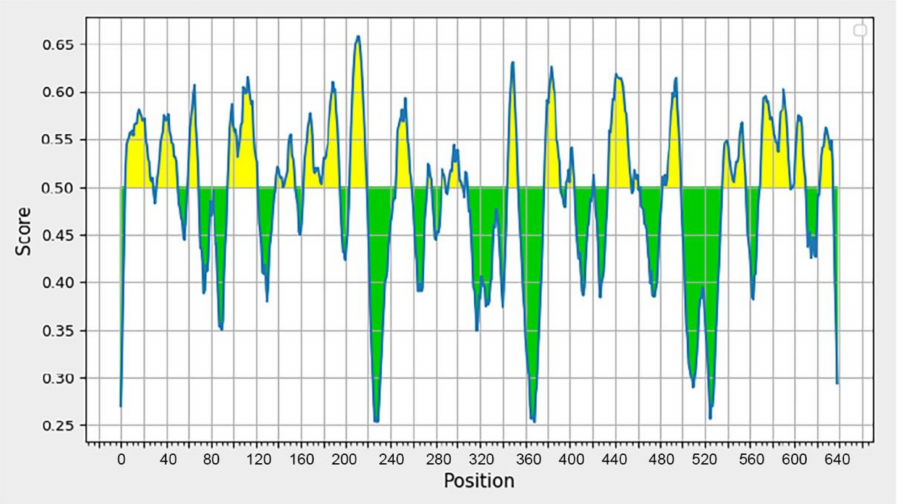
Figure 2. Graph displaying the results of B-cell epitope prediction using BepiPred Linear Epitope Prediction 2.0. The graph illustrates two prediction areas: the area with a yellow peak over the red line (threshold), indicating the area of the B-cell epitope, and the area with a green peak, which is not the prediction area for the B-cell epitope.